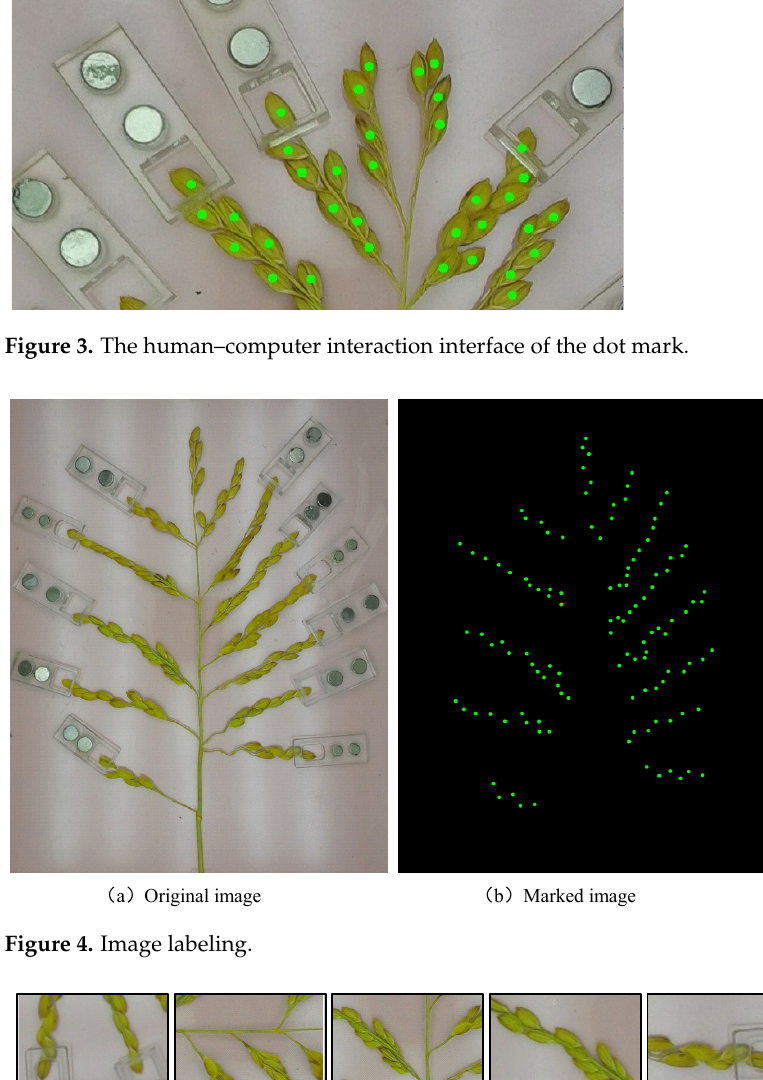
Figure 5. Generated sub-images.